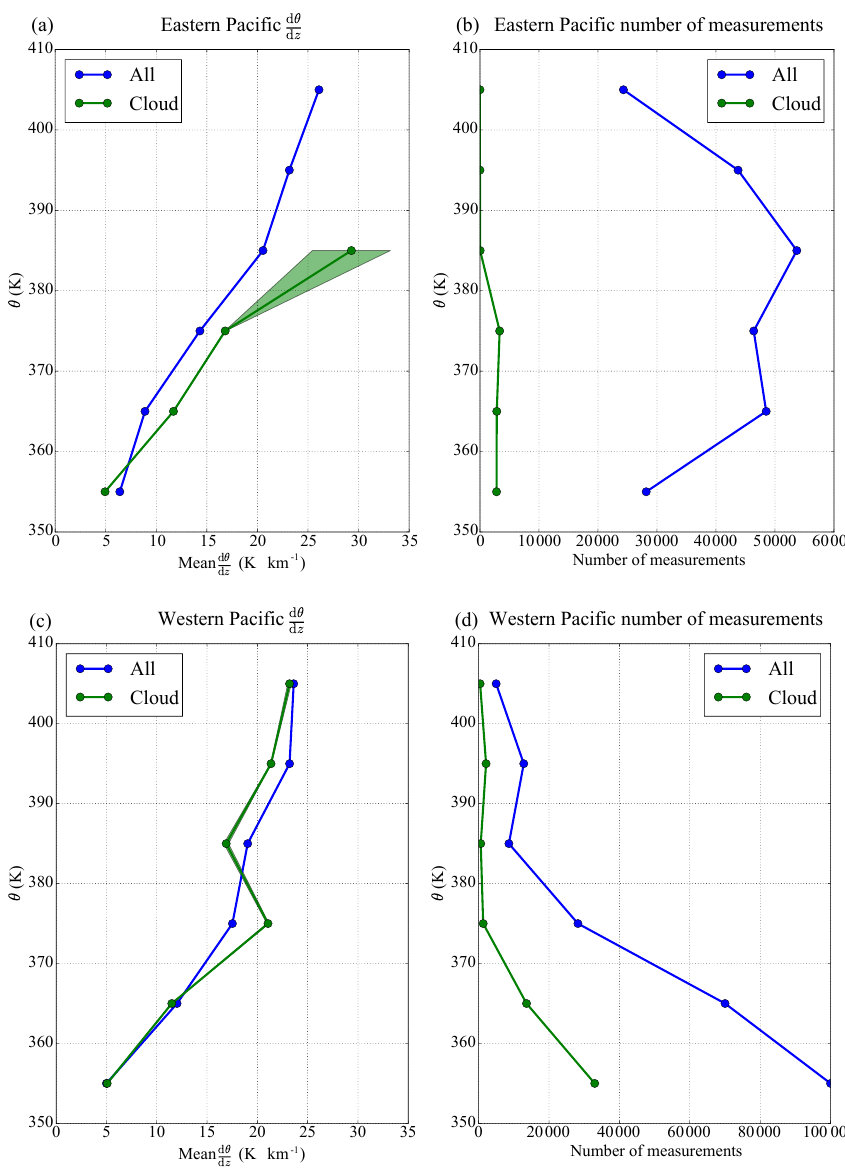
Figure D1. (a, c) Average potential temperature vertical gradient d θ in cloudy and cloud-free air in the eastern (a, b) and western Pa- d z cific (c, d) . Panels (b, d) show the total and in cloud number of measurements as a function of altitude. In (a, c) , the 1 σ uncertainties are represented by shadings, but the amount of measurements are sufficient to make them indiscernible. This is nevertheless no statistical proof since the data come only from a few flights and are